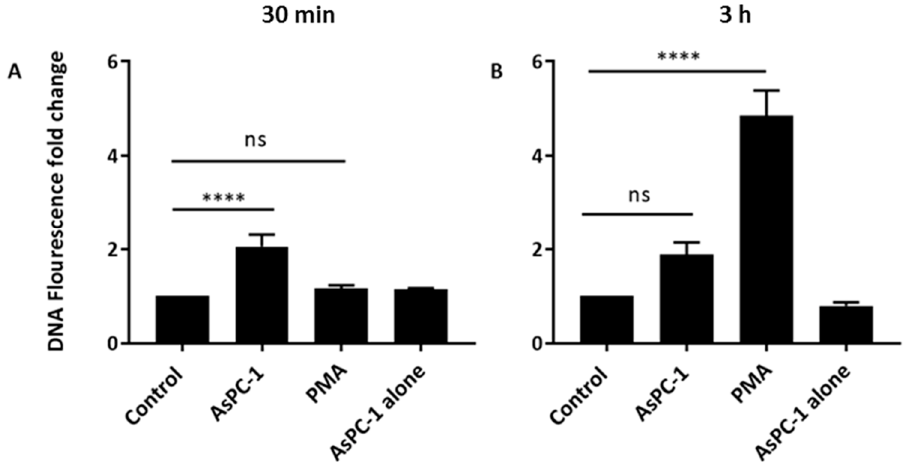
Figure 1. AsPC-1 stimulates the rapid release of neutrophil extracellular traps (NETs) from human neutrophils. Human neutrophils were incubated with AsPC-1 cells at a neutrophil to AsPC-1 ratio of 1:2 and NETs were quantified using Sytox Green (5 μ M) in a fluorescence plate reader at ( A ) 30 min and ( B ) 3 h. AsPC-1 induced rapid NET release at 30 min while phorbyl myristate acetate (PMA)- stimulated neutrophils (positive control) required 3 h. Control: unstimulated neutrophils. ( n = 12, **** p < 0.0001 and ns = non-significant); One-way ANOVA followed by Bonferroni post-test. Data presented as mean ± SEM.